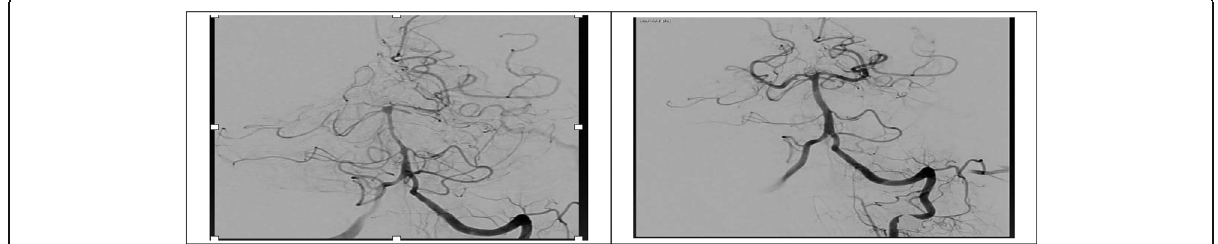
Fig. 1 Patient with left MCA vasospasm (left) undergo intervention and improvement of the MCA blood flow after intra-arterial nimodipine injection